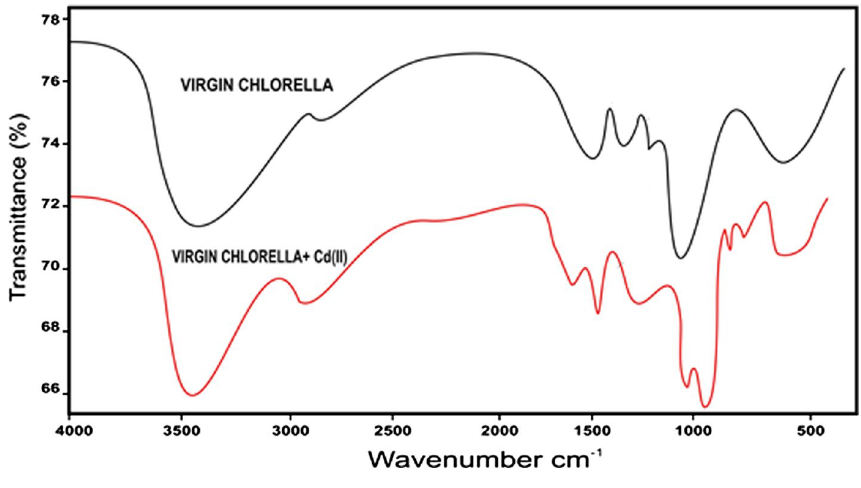
Fig. 3 Scanning electron microscopic images of a virgin biomass of Chlorella vulgaris , b Cd (II) loaded biomass of Chlorella vulgaris